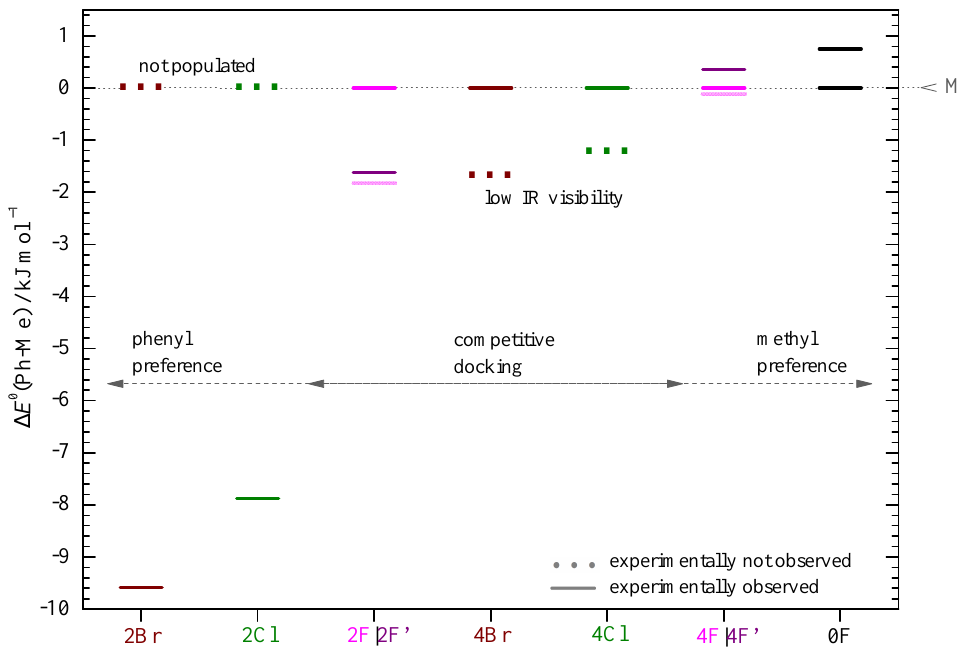
Figure 6. ZPE corrected energy differences ∆ E 0 (Ph-Me) in kJmol − 1 (B3LYP-D3(BJ,abc)/def2-TZVP) for each system referenced to the corresponding methyl sided coordination (Me) (see Table S4 in the Supporting Information) at ∆ E 0 = 0kJmol − 1 . In 2Br and 2Cl, only the Ph sided structure and for the other systems at least the Me sided structure is experimentally observed (continuous line). The situation is unclear (light continuous line) only for 2F and